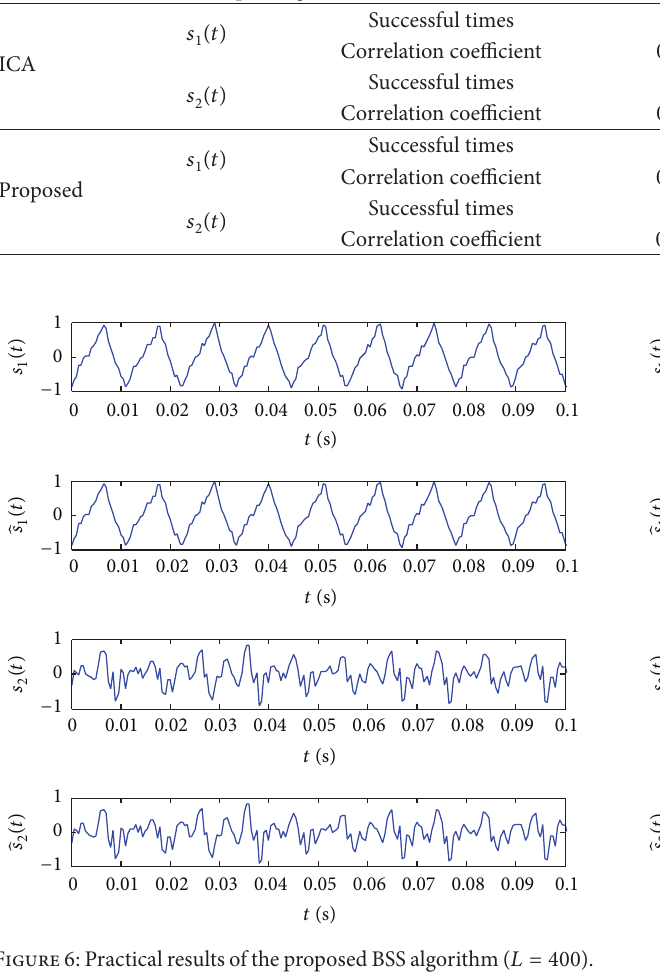
Figure 6: Practical results of the proposed BSS algorithm ( 𝐿 = 400 ).